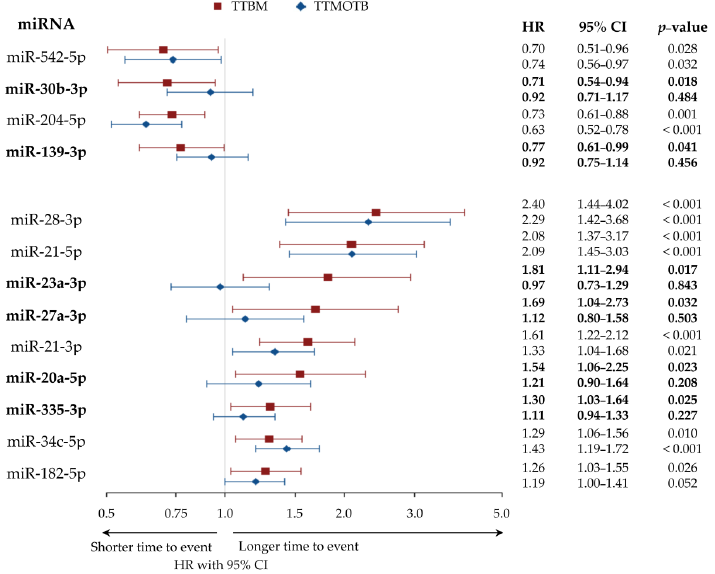
Figure 2. Forest plot displaying HR with 95% CI of TTBM and TTMOTB for 13 miRNA sig- nificantly associated with TTBM (univariate Cox proportional hazards model). Note: miRNA correlated with TTBM but not with TTMOTB are highlighted in bold. Abbreviations: miRNA = microRNA, TTBM = time to bone metastasis, TTMOTB = time to metastasis other than bone, miR = microRNA, HR = hazard ratio, CI = confidence